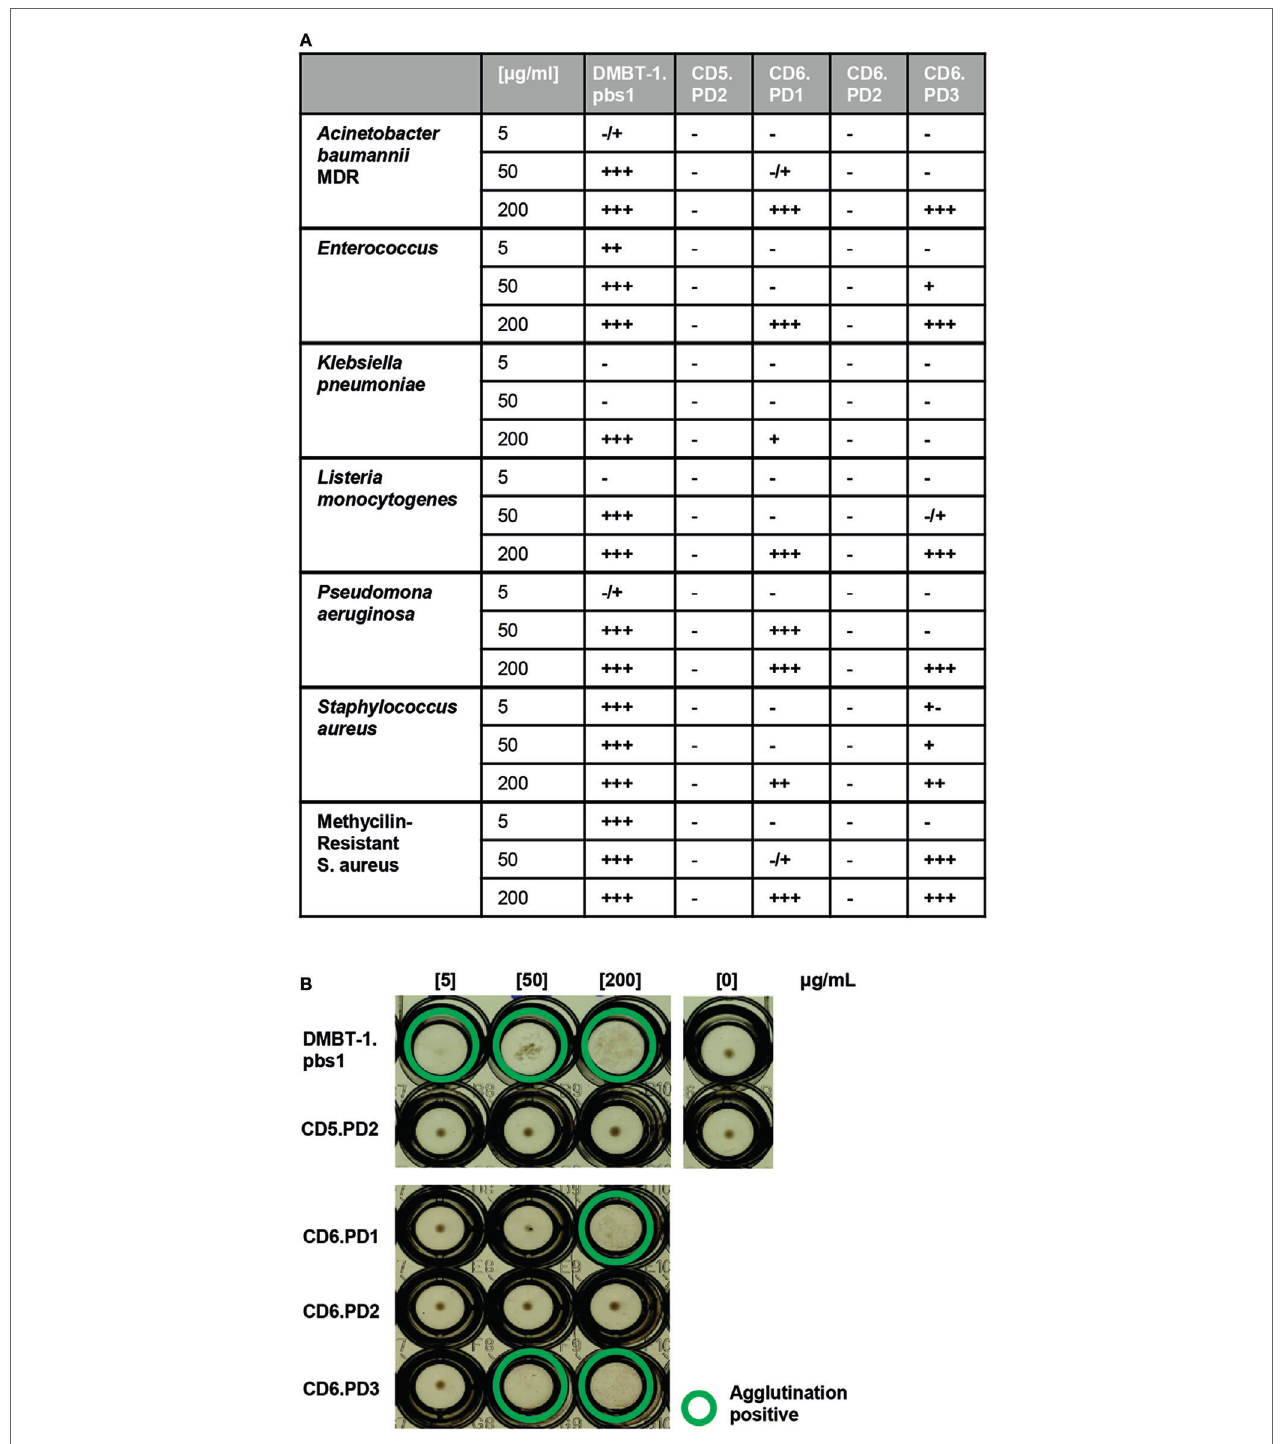
FigUre 2 | Bacterial agglutination properties of CD6-derived peptides. Increasing concentrations (5, 50, and 200 µg/mL) of the indicated CD6 (PD1, PD2, and PD3), deleted in malignant brain tumors-1 (DMBT-1) (pbs1; C + ), and CD5 (PD2; C − )-derived peptides were incubated for 2 h at room temperature in 96-well U-bottomed plates with alive bacterial cell suspensions [75 × 10 6 colony-forming units (CFU)/mL] in TTC buffer. Bacterial agglutination was scored and consensed by two independent observers as − , ± , + , + + , or +++ . (a) Summary of the agglutination results obtained with the indicated panel of Gram-negative (multidrug- resistant Acinetobacter baumannii clinical isolate; Enterobacter cloacae ATCC 23355; Escherichia coli ATCC 25922; Klebsiella pneumoniae ATCC 13883; Listeria monocytogenes ATCC 19111; and Pseudomonas aeruginosa ATCC 27853) and Gram-positive [ Staphylococcus aureus ATCC 25923; methicillin-resistant S. aureus (MRSA) clinical isolate] bacterial strains. (B) Representative agglutination results obtained for the MRSA clinical isolate.